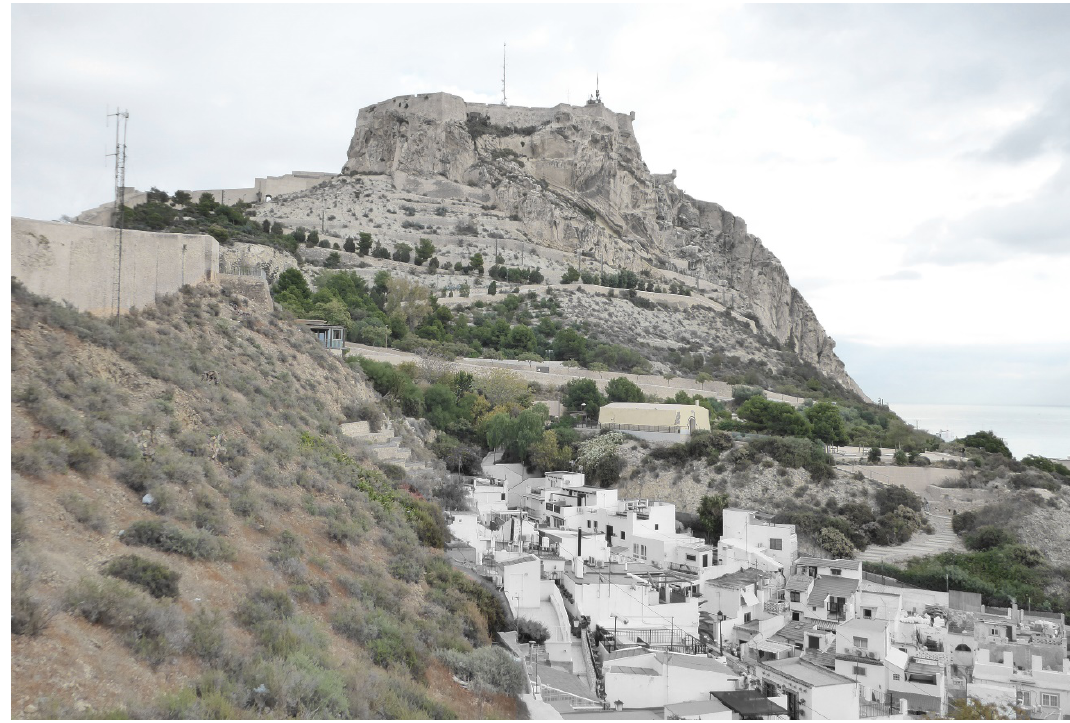
Figure 5. Image of the Castle of Santa Barbara from its southern side, recognised as the “face of the Moor”, on the same slope where the Ereta magazine is